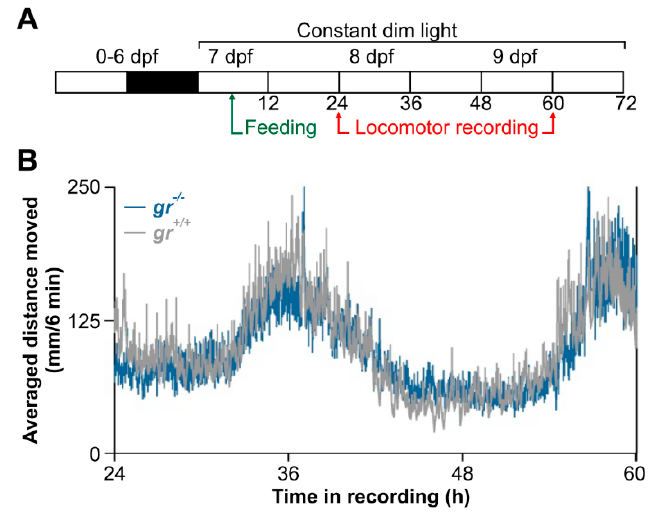
Figure 3. Circadian activity rhythms of gr +/+ and gr − / − larvae zebrafish. ( A ) Larvae were reared under light–dark (LD) cycle from 0 to 6 dpf and then maintained for 3 days in constant dim light (LL). Locomotor activity were recording from 24 to 60 h in LL. ( B ) Mean waveform of locomotor activity under LL for 36 h (n = 144/genotype).